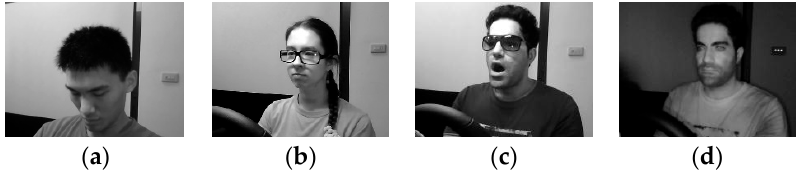
Figure 9. Sample image from the National Tsing Hua University-Driver Drowsiness Detection (NTHU-DDD) dataset. ( a ) Bareface (nodding); ( b ) wearing glasses (normal); ( c ) wearing sunglasses (yawning); and ( d ) bareface at night (normal).